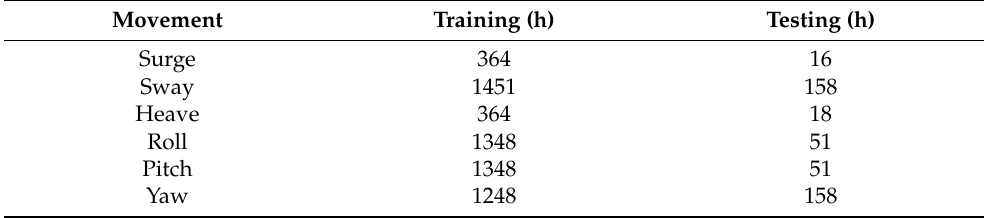
Table 1. Dataset: available data for each movement and purpose (training or testing).